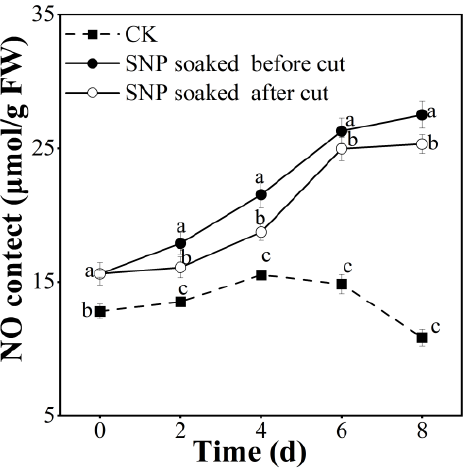
Figure 7. Effect of SNP treatment on NO content of fresh-cut potatoes. Different letters indicate significant differences among treatments at same storage time ( p < 0.05).